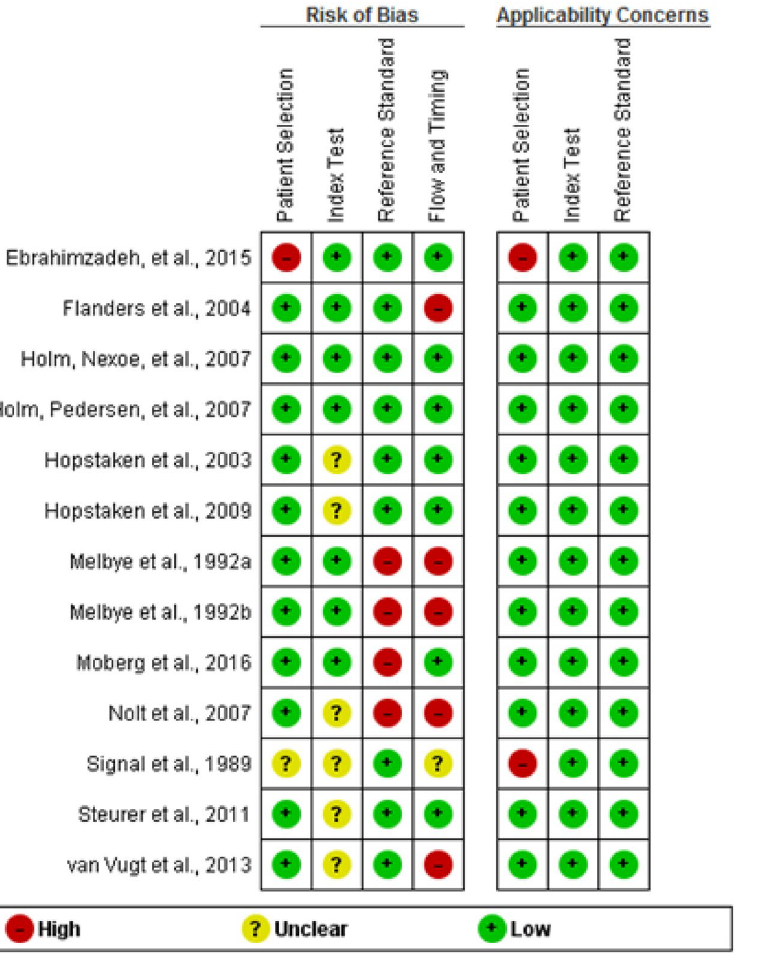
Figure 3. Summary of risk of bias and applicability